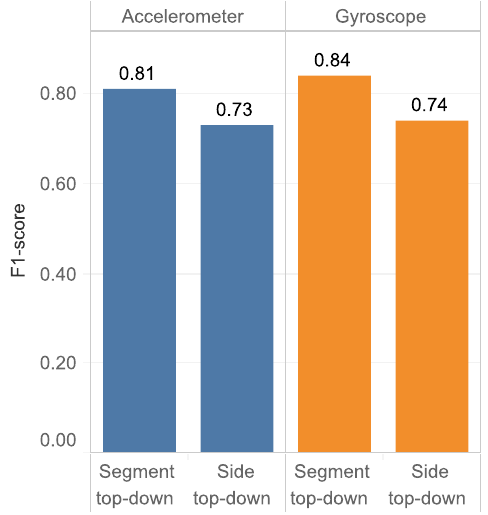
Figure 7. The comparison of final results based on different hierarchical